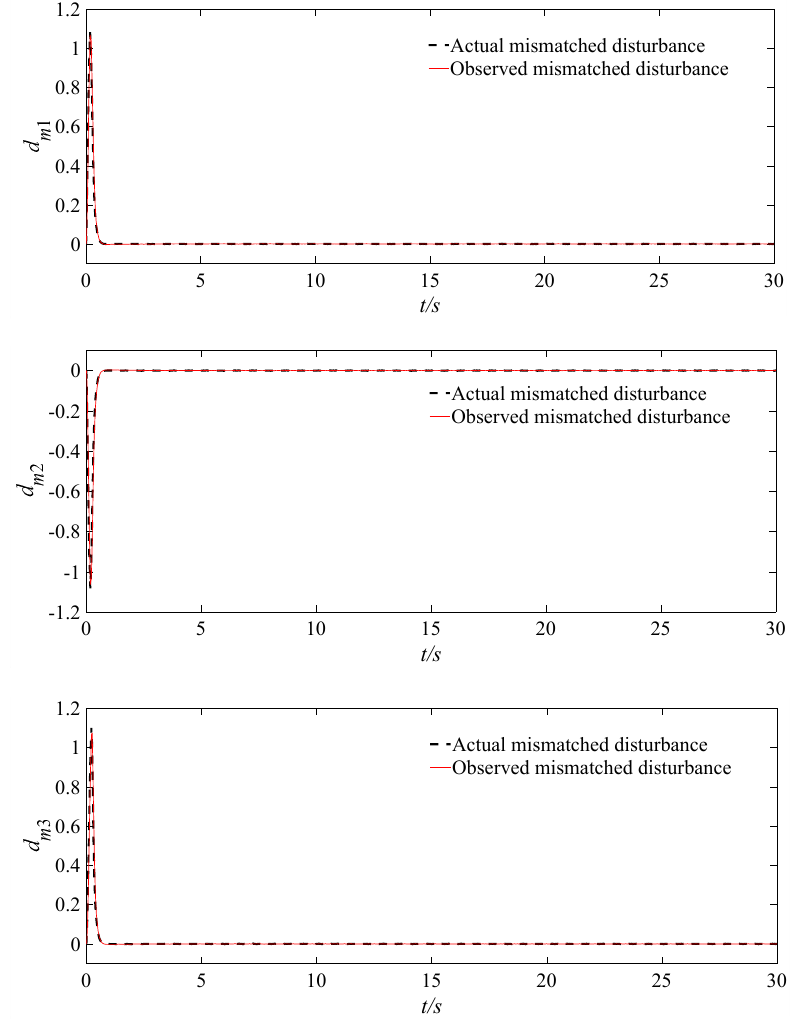
Figure 2. The responses of actual and observed mismatched disturbances d m .